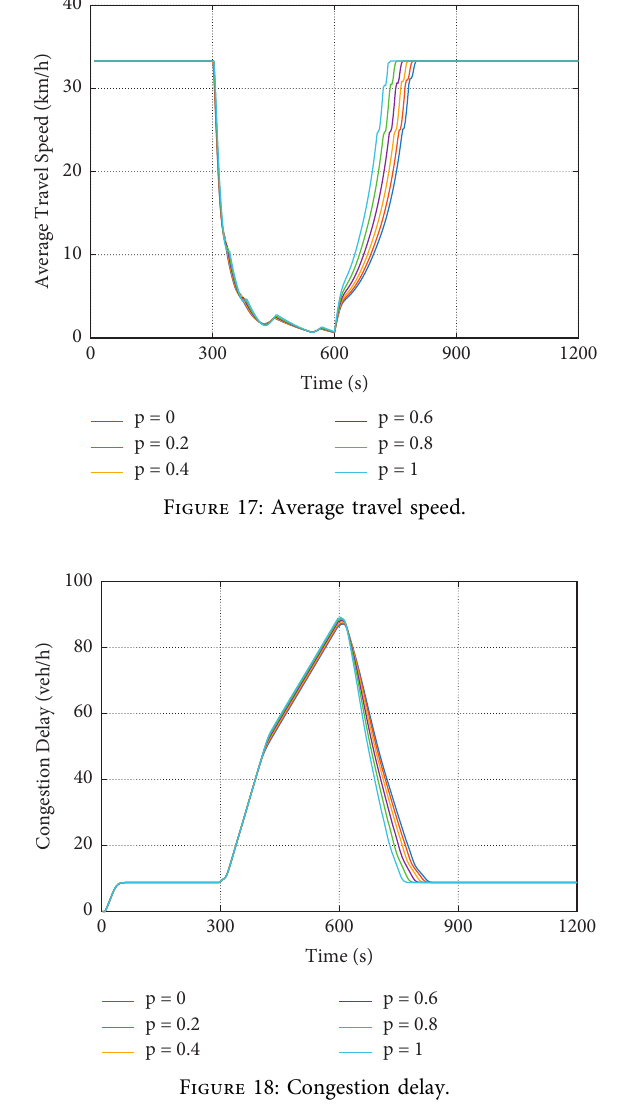
Figure 18: Congestion delay.